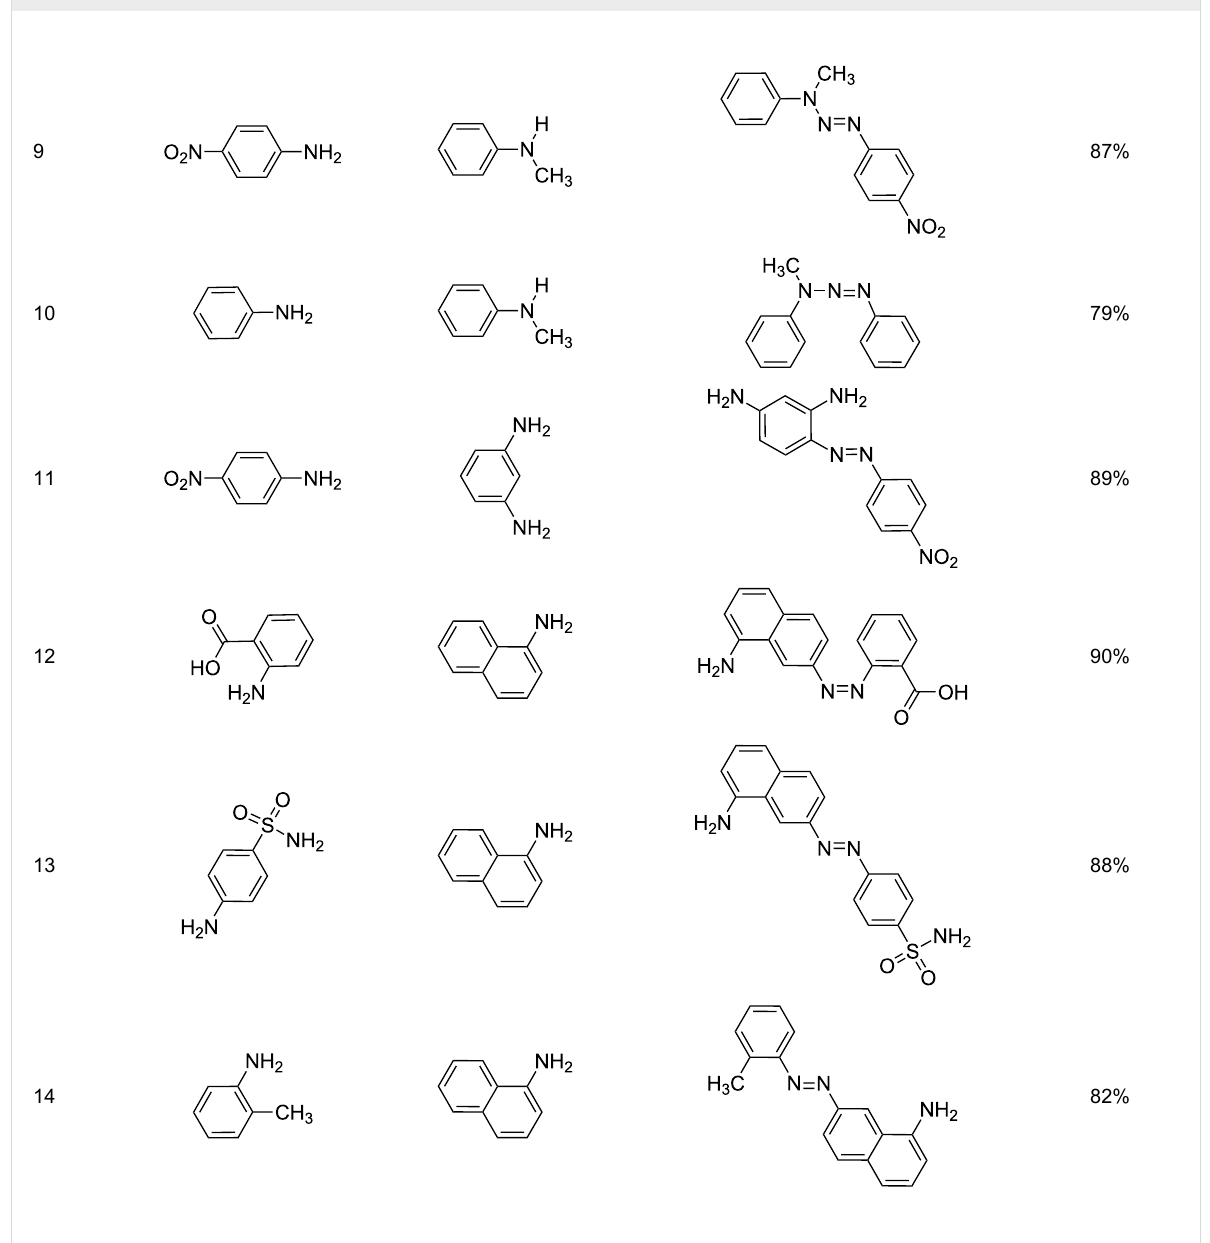
Table 7: Azo compounds synthesized under alkaline and acidic azo coupling conditions.